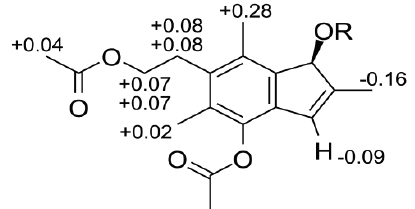
the R-MTPA monoester of 1a . The data was obtained in acetone- d